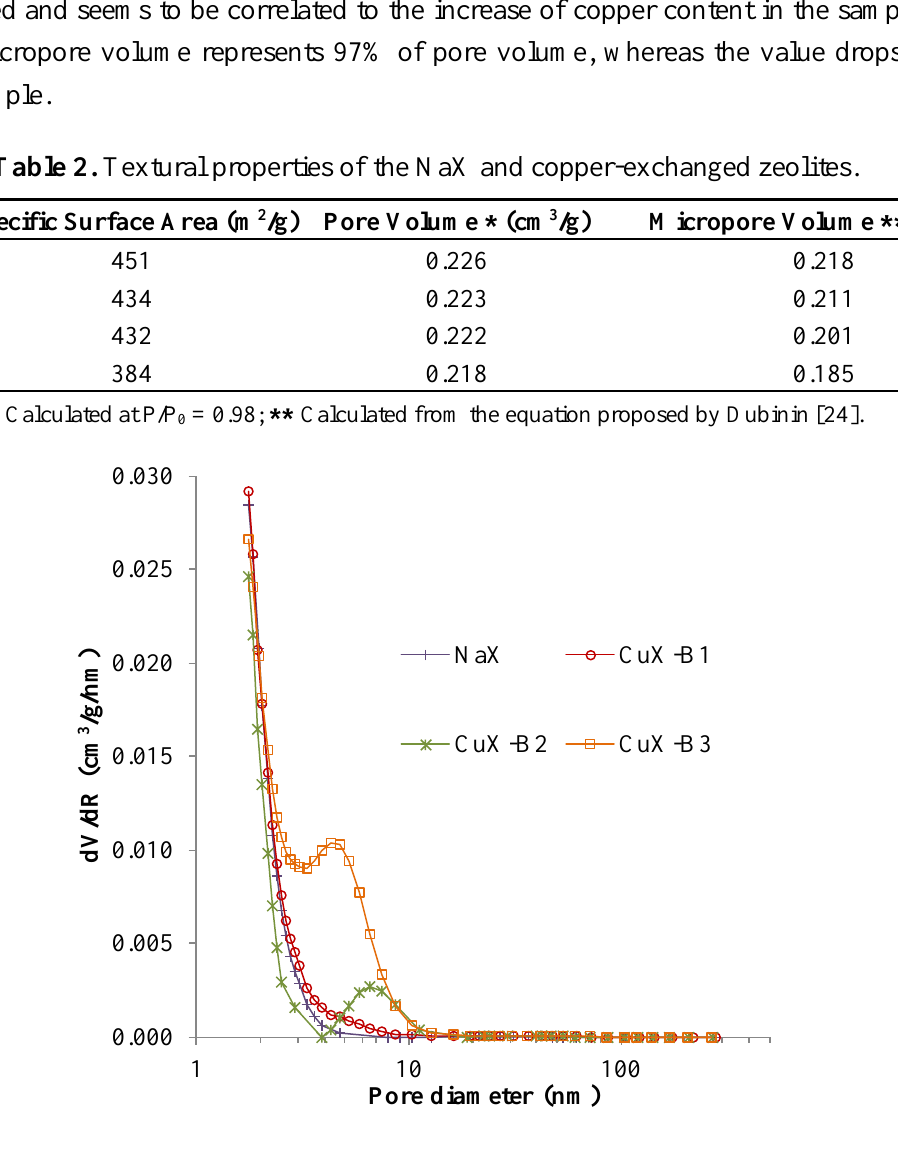
Figure 4. Pore size distribution of the CuX-B materials and the parent NaX